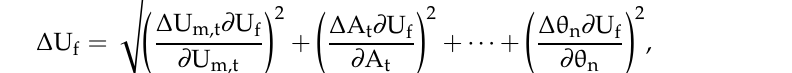
Figure 8. View of the tested window frame in the surround panel on the warm side.